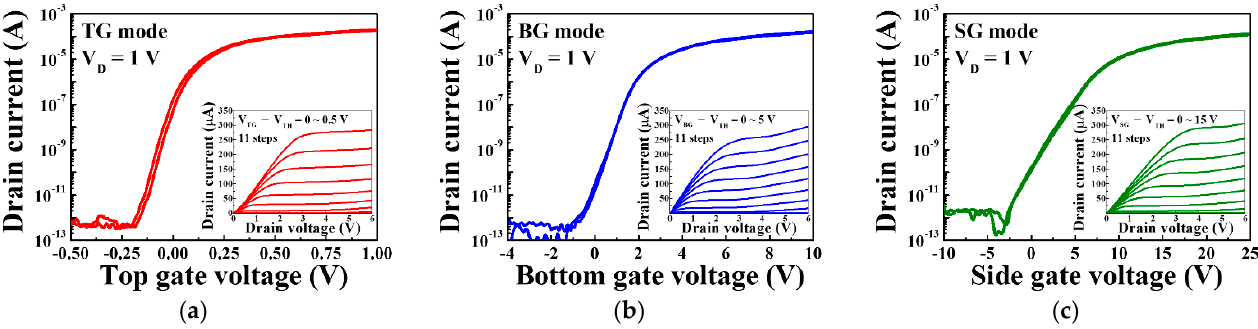
Figure 6. Transfer characteristic curves of triple-gate a-IGZO TFTs operating in the ( a ) TG, ( b ) BG, and ( c ) SG modes. The insets show the output characteristic curves corresponding to each operating mode.